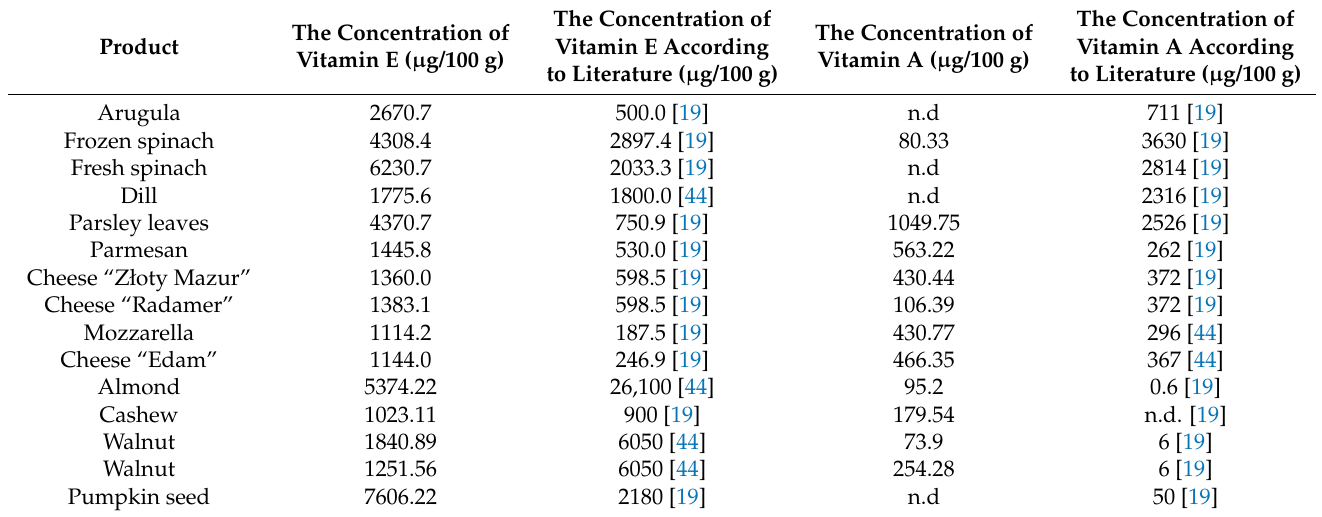
Table 1. Vitamins A and E analyses in real food